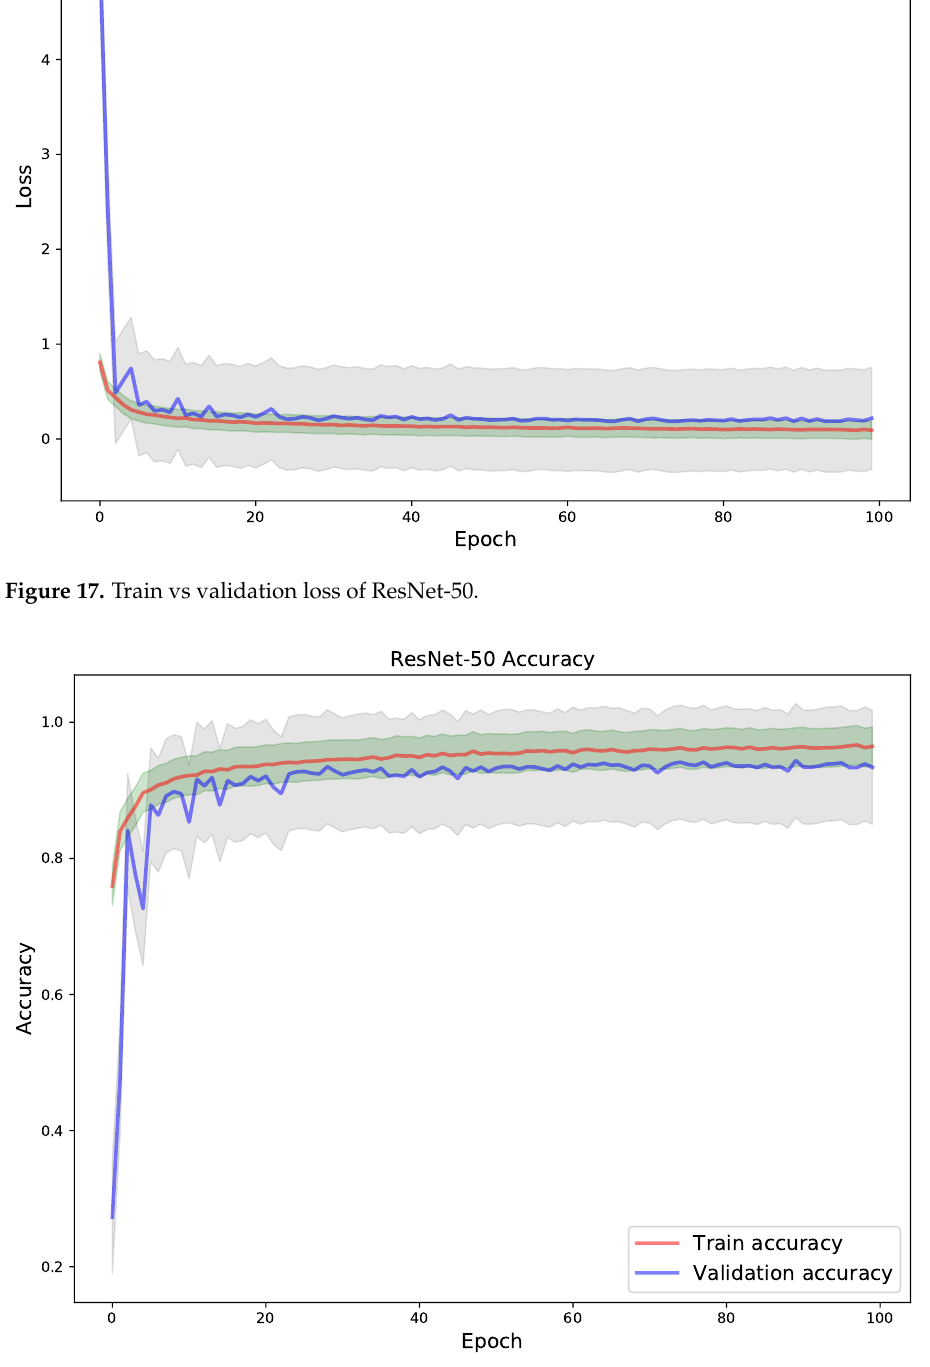
Figure 18. Train vs validation accuracy of